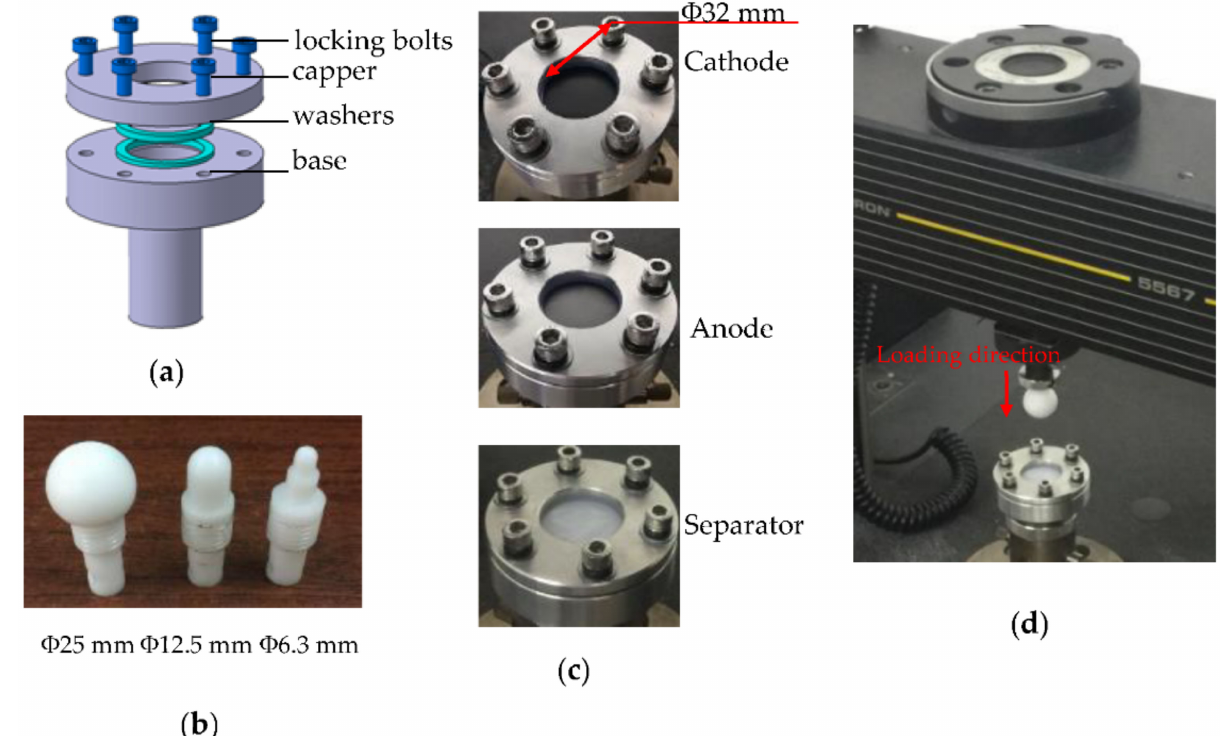
Figure 4. Biaxial experimental setup and test specimens: ( a ) Fixture; ( b ) Spherical punches; ( c ) Biaxial test specimens; ( d ) Biaxial experimental